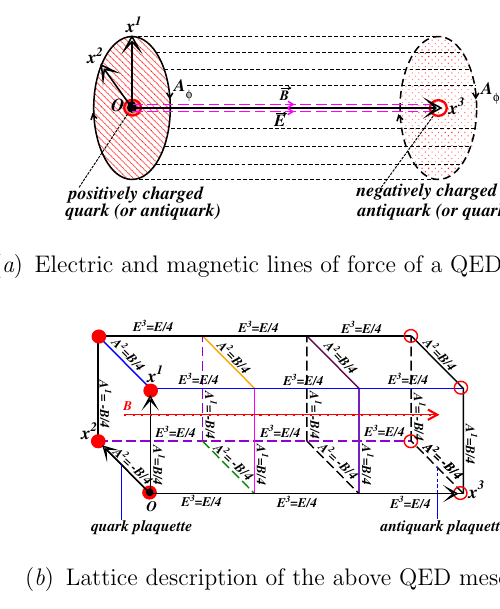
Fig. 33 a The3Dyo-yomotionfortheboundstate,reachingamomen- tary snapshot of the flux tube in the stretch (2 + 1)D configuration. b The upper figure transcribed in terms of the lattice link and plaquette